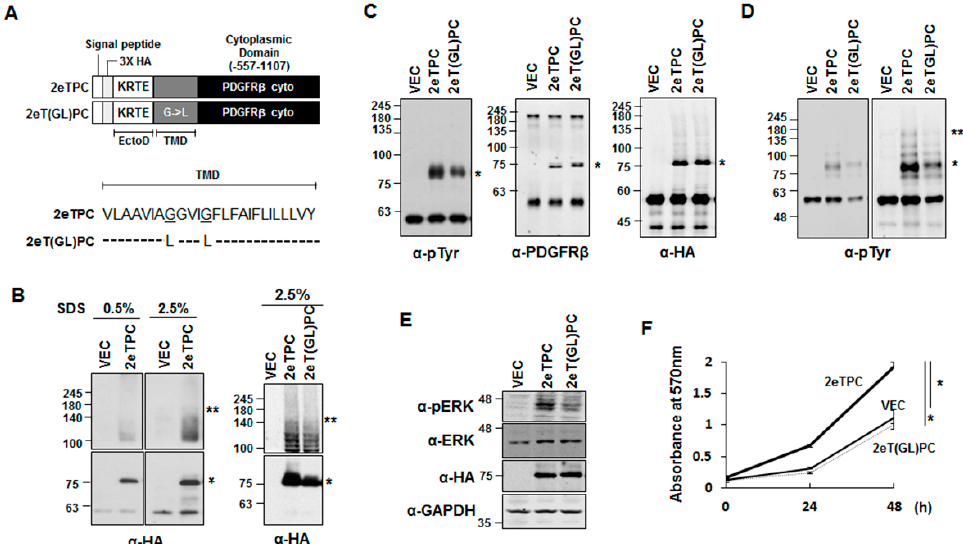
Figure 4. Syndecan-2 transmembrane domain induces SDS-resistant oligomerization of syndecan-2/PDGF receptor chimeras. ( A ) Schematics of the 2eTPC and 2eT(GL)PC chimeras in which four amino acid residues of the extracellular domains of rat syndecan-2 ( KRTE ) and the corresponding TMDs were linked to the cytoplasmic domain of the human PDGF ( PC ). ( B ) HEK293T cells expressing 2eTPC proteins were lysed with lysis buffer containing SDS (0.5 and 2.5%) and separated by 8 or 10% SDS-PAGE, and the proteins were detected using an anti-HA antibody. The migration positions of the SDS-resistant dimer (**) and monomer (*) are indicated. ( C ) HEK293T cells expressing the vector (vec), 2eTPC, or 2eT(GL)PC were lysed with RIPA buffer containing 2.5% SDS, and the cell lysates were diluted with RIPA buffer (final 1.25% SDS), immunoprecipitated with an anti-HA antibody, and analyzed by Western blotting with the indicated antibodies. ( D ) HEK293T cells expressing the indicated constructs were starved in 1% FBS for 24 h. Whole-cell lysates were pulled down using an anti-HA antibody and analyzed by Western blotting using an anti-pTyr antibody. ( E ) HEK293T cells expressing the indicated cDNAs were lysed using RIPA buffer, and MAPK activation was assessed using a phospho-specific antibody (pErk). ( F ) Cells were plated to 96-well plates and incubated for the indicated periods of time. Proliferated cells were measured by MTT assay. The data shown are representative of three independent experiments. Bars represent average ± standard deviation; * p <